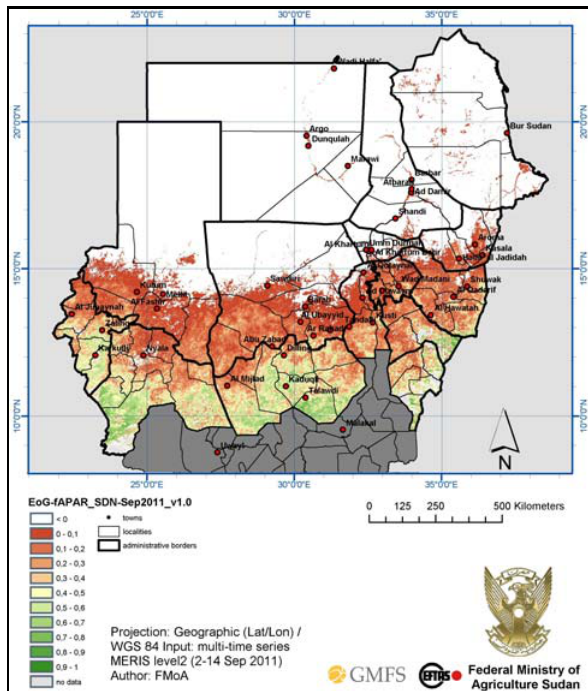
Figure 4 Indicative inter seasonal vegetation growth map (fapar-EoG) for September 2011